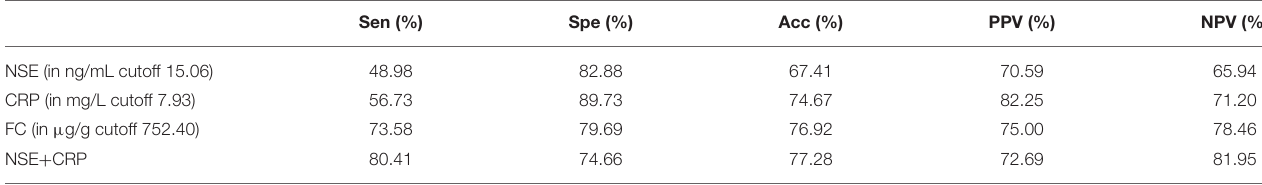
TABLE 3 | Sen, Spe, Acc, PPV, and NPV for serum NSE, CRP, and FC in discriminating between patients with CD and healthy people. Sen (%) Spe (%) Acc (%) PPV (%) NPV (%) NSE (in ng/mL cutoff 15.06)